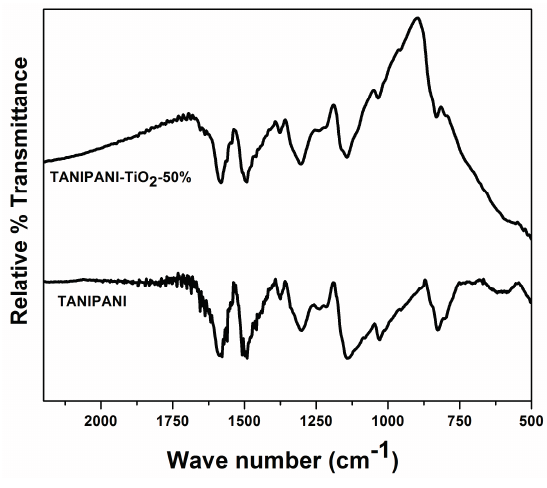
Figure 4. Fourier Transform-Infrared spectra of dedoped TANIPANI-TiO 2 and TANIPANI powder